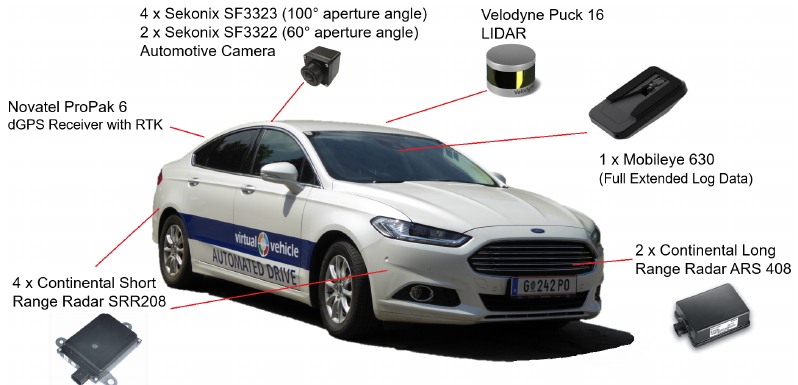
Figure 4. Ford Mondeo demonstrator vehicle with additionally installed sensors. For the implemen- tation presented in this paper, only the Mobileye 630 was